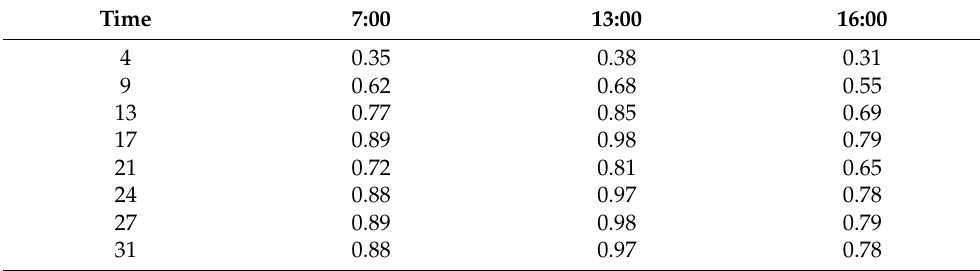
Table A4. The magnitude of the 11th harmonic current of each harmonic source at different times